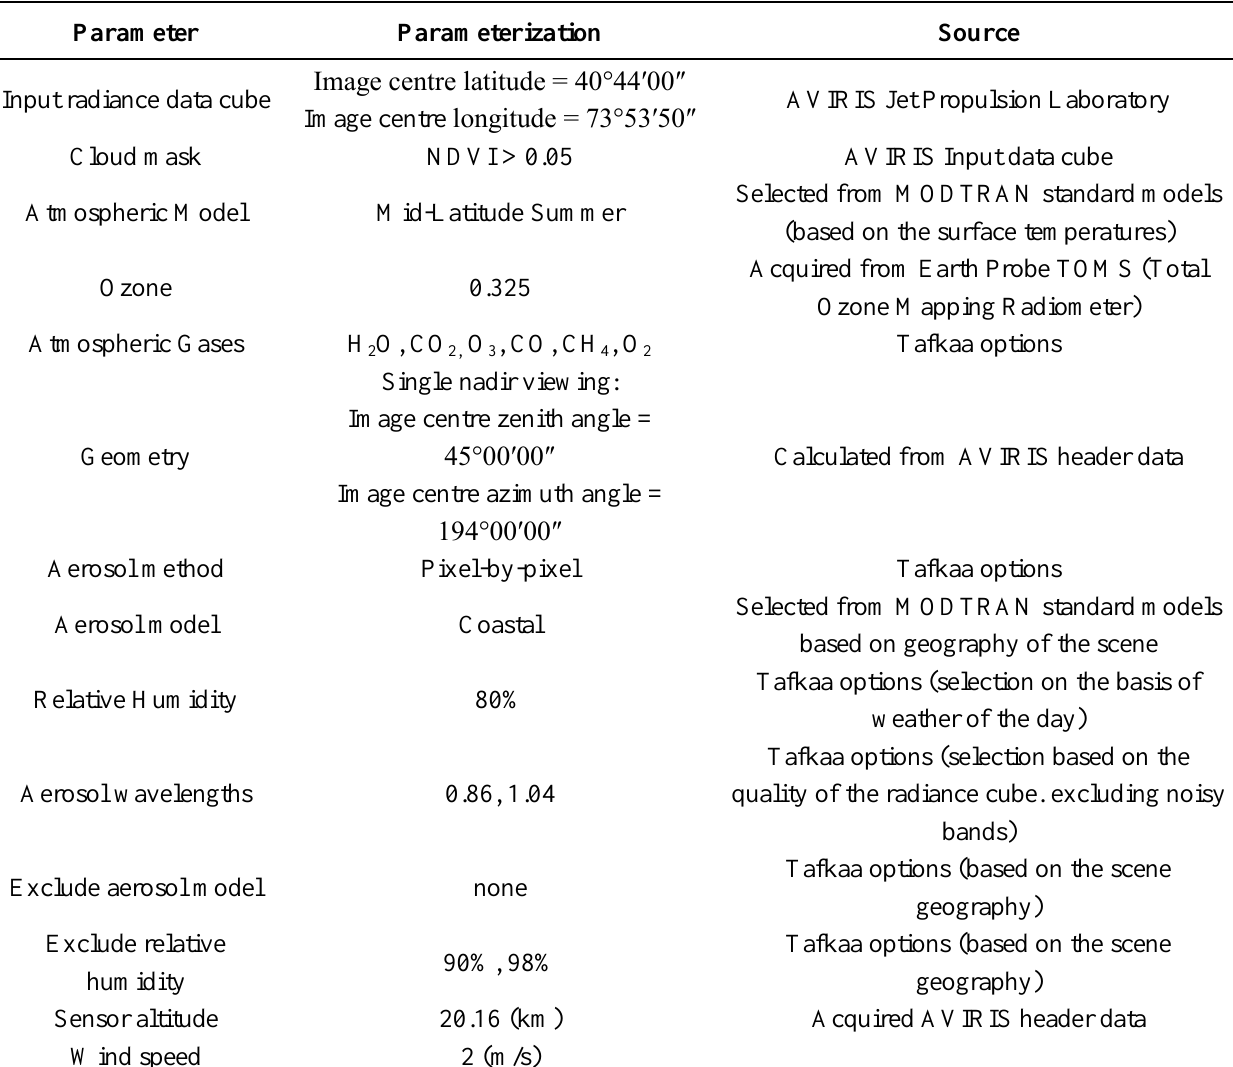
Table 2. Tafkaa atmospheric parameters applied to AVIRIS